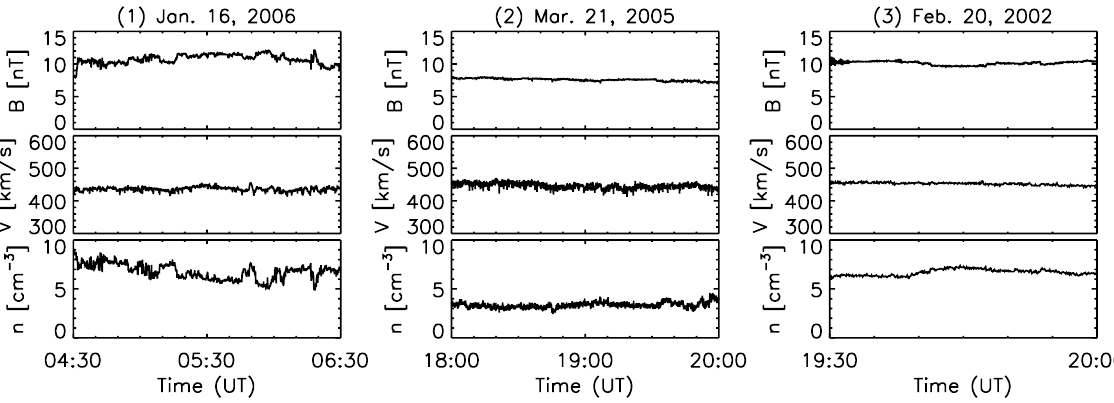
Fig. 1. Three time intervals displaying magnetic field magnitude, flow speed, and ion density in the solar wind. The data were obtained by fluxgate magnetometer (FGM) and electrostatic ion analyzer (CIS-HIA) on board Cluster-1 spacecraft.